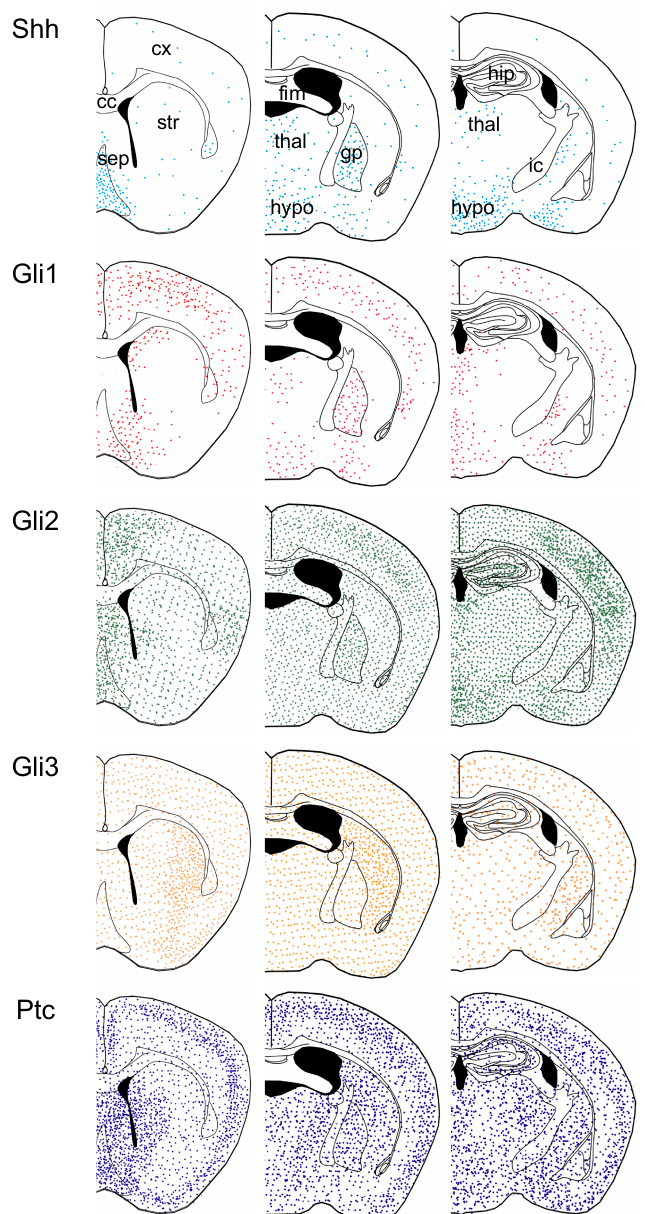
Figure 1. Schematic depicting the relative distribution of various components of the Shh signaling pathway in the intact, adult forebrain across the anterior–posterior axis. Data derived from genetic labeling, as reported by Garcia et al. (2010), and in situ hybridization studies [18,19,45]. Note the relative concordance in distribution of cells expressing Shh and Gli1 , whereas cells expressing Gli2 , Gli3 , and Ptc are found in several regions where Gli1 expression is absent. Shh is expressed by neurons, whereas Gli1 , Gli2 , Gli3 , and Ptc are expressed by astrocytes [14]. cc, corpus callosum; cx, cortex; fim, fimbria; gp, globus pallidus; hip, hippocampus; hypo, hypothalamus; ic, internal capsule; sep, septum; str, striatum; thal, thalamus.